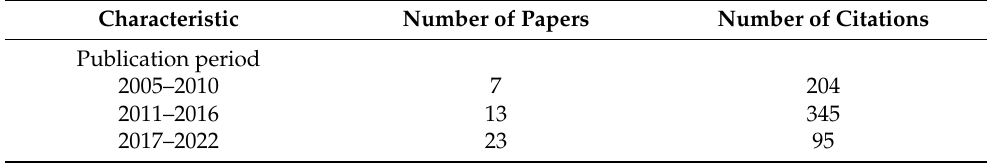
Table 2. Publication period of the selected